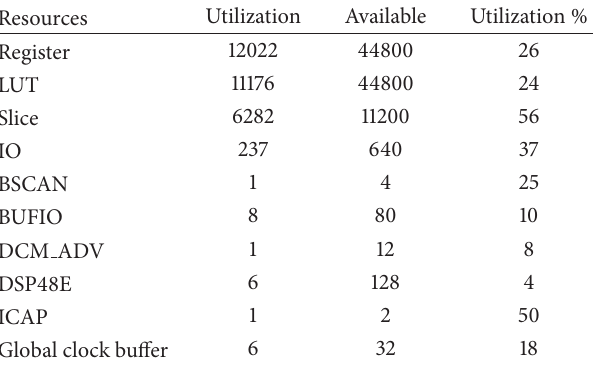
Table 10: Resources utilization for the system on a Virtex-V FPGA (XC5VFX70T), freq. 100MHz. Resources